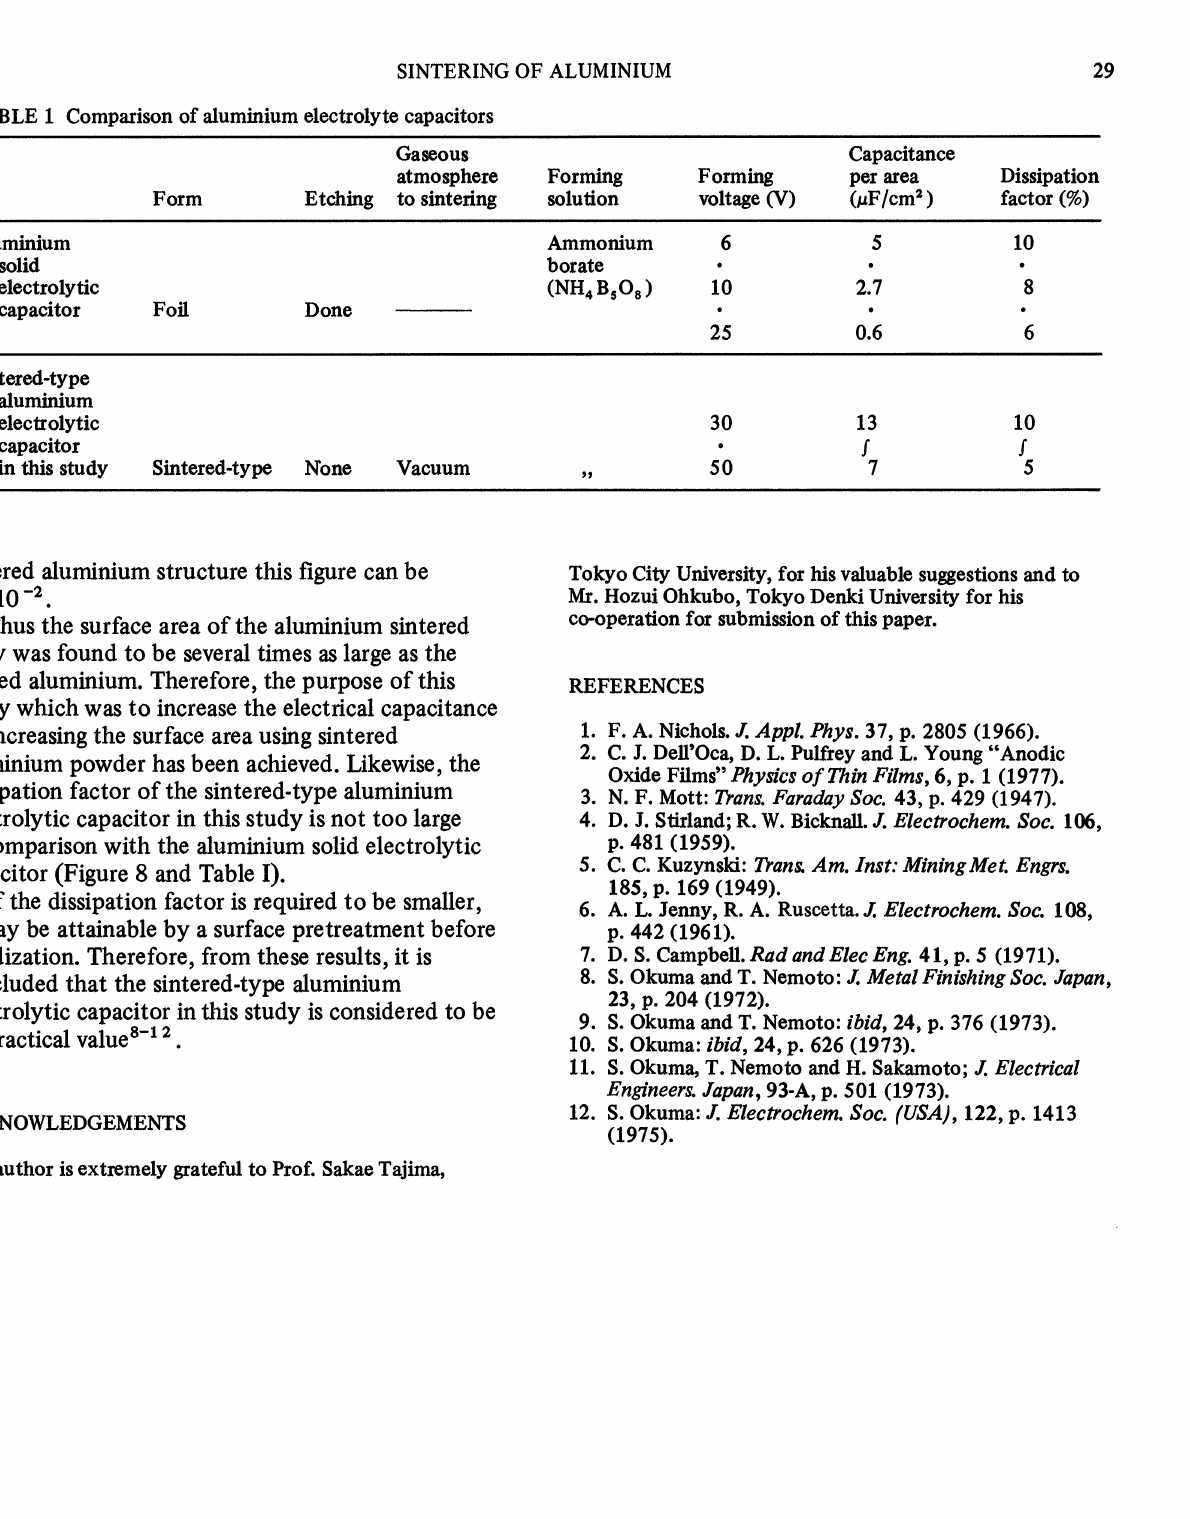
TABLE 1 Comparison of aluminium electrolyte capacitors Form Aluminium solid electrolytic